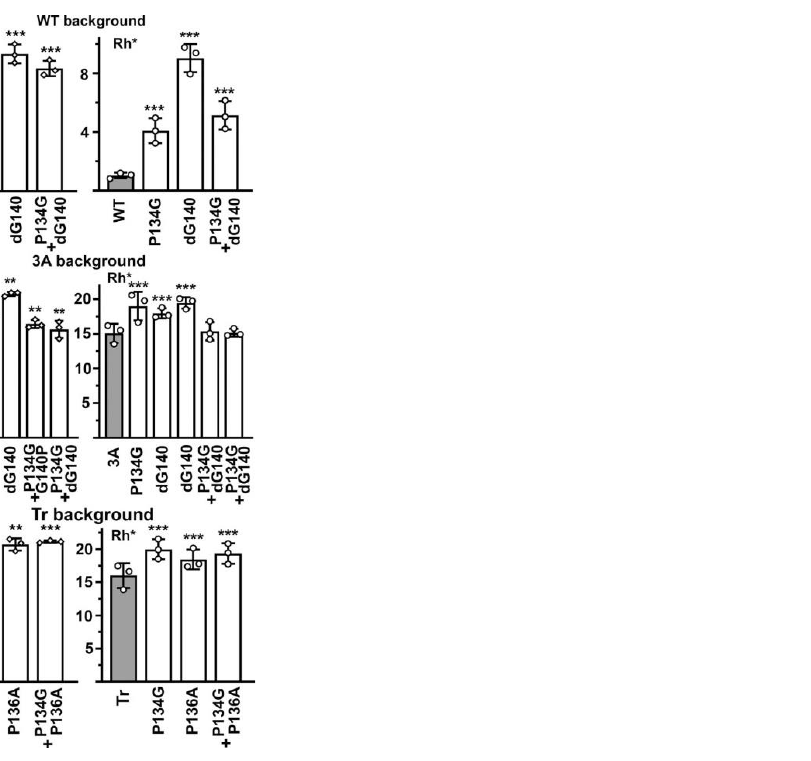
Figure 6. Combinations of binding-enhancing mutations do not yield additive effects on any background. The binding of indicated mutants of arrestin-1 to P-Rh* and Rh* was determined using radiolabeled arrestins, produced in cell-free translation, in the direct binding assay with purified phospho- rylated or unphosphorylated light-activated bovine rhodopsin, as described in Methods. Circles represent individual measurements performed in duplicate ( n = 3). The binding to P-Rh* and Rh* was analyzed separately in each group. Statistical significance of the differences between WT or background mutants (darker shaded bars) and the arrestin-1 middle loop mutants was determined by ANOVA and Dunnet post hoc test and is indicated as follows: * p < 0.05; ** p < 0.01; *** p < 0.001 to WT, 3A, or Tr,